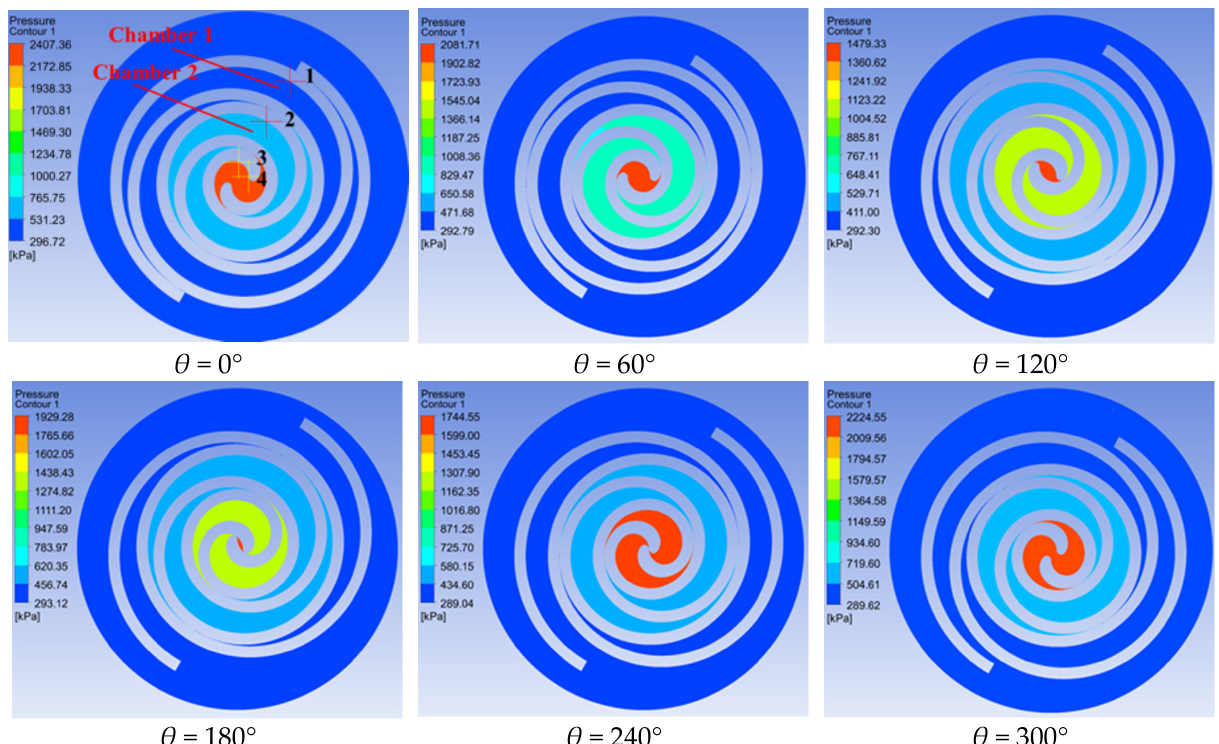
Figure 8. Pressure distribution at di ff erent rotational angles of 9000 rpm.